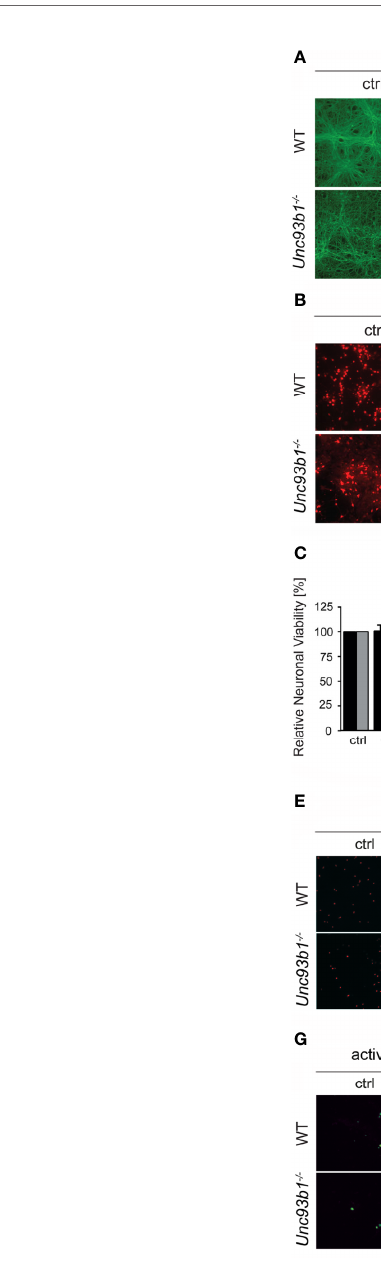
FIGURE 5 | UNC93B1 is required for let-7b -induced cell-autonomous neuronal apoptosis in vitro . (A, B) Enriched cortical neurons isolated from C57BL/6 (wild-type, WT) and Unc93b1 -/- mice were exposed to 10 µg/ml let-7b for 72 h or were left untreated (control). Mutant oligoribonucleotide (5 µg/ml) served as negative control. LPS (100 ng/ml) was used to indicate functionally relevant microglia cell numbers in the enriched neuronal cell cultures. Loxoribine (10 mM) served as positive control for TLR7-dependent neuronal injury. Subsequently, cells were immunolabeled using Neuro fi lament (A) and NeuN (B) antibodies to assess axonal damage and neuronal viability, respectively. (C, D) Cell cultures derived from WT and Unc93b1 -/- mice described above were incubated with various doses of let-7b , as indicated, for 72 h (C) or treated with 5 µg/ml let-7b for different time periods, as indicated (D) . (E – H) WT cortical neurons were incubated with let-7b (5 µg/ml) for various time periods, as indicated, and were subsequently analyzed by (E) TUNEL assay and (G) immunostaining using active caspase-3 antibody. DAPI staining marked all present cells. Subsequently, TUNEL-positive and caspase-3-positive cells were quanti fi ed and normalized against DAPI-positive cells ( F and H , respectively). Mutant oligoribonucleotide served as negative control, while loxoribine and LPS were used as positive control. (C – H) At least three independent experiments were performed. Data are expressed as mean ± SEM. Kruskal-Wallis test was used to determine global signi fi cance over all conditions [ (C) p = 0.0042 over WT and p = 0.9557 over Unc93b1 -/- ; (D) p = 0.0036 over WT and p = 0.9971 over Unc93b1 -/- ; (F) p < 0.0001 over WT and p = 0.3514 over Unc93b1 -/- ; (H) p = 0.0010 over WT and p = 0.0036 over Unc93b1 -/- ]. P values of relevant groups (indicated condition vs. unstimulated control, ctrl) were determined by Dunn ’ s multiple comparison test. P values between respective groups of WT vs. Unc93b1 -/- (in brackets) were assessed by unpaired Student ’ s t test. * p < 0.05; ** p < 0.01; *** p < 0.001; **** p < 0.0001. Scale bar, 50